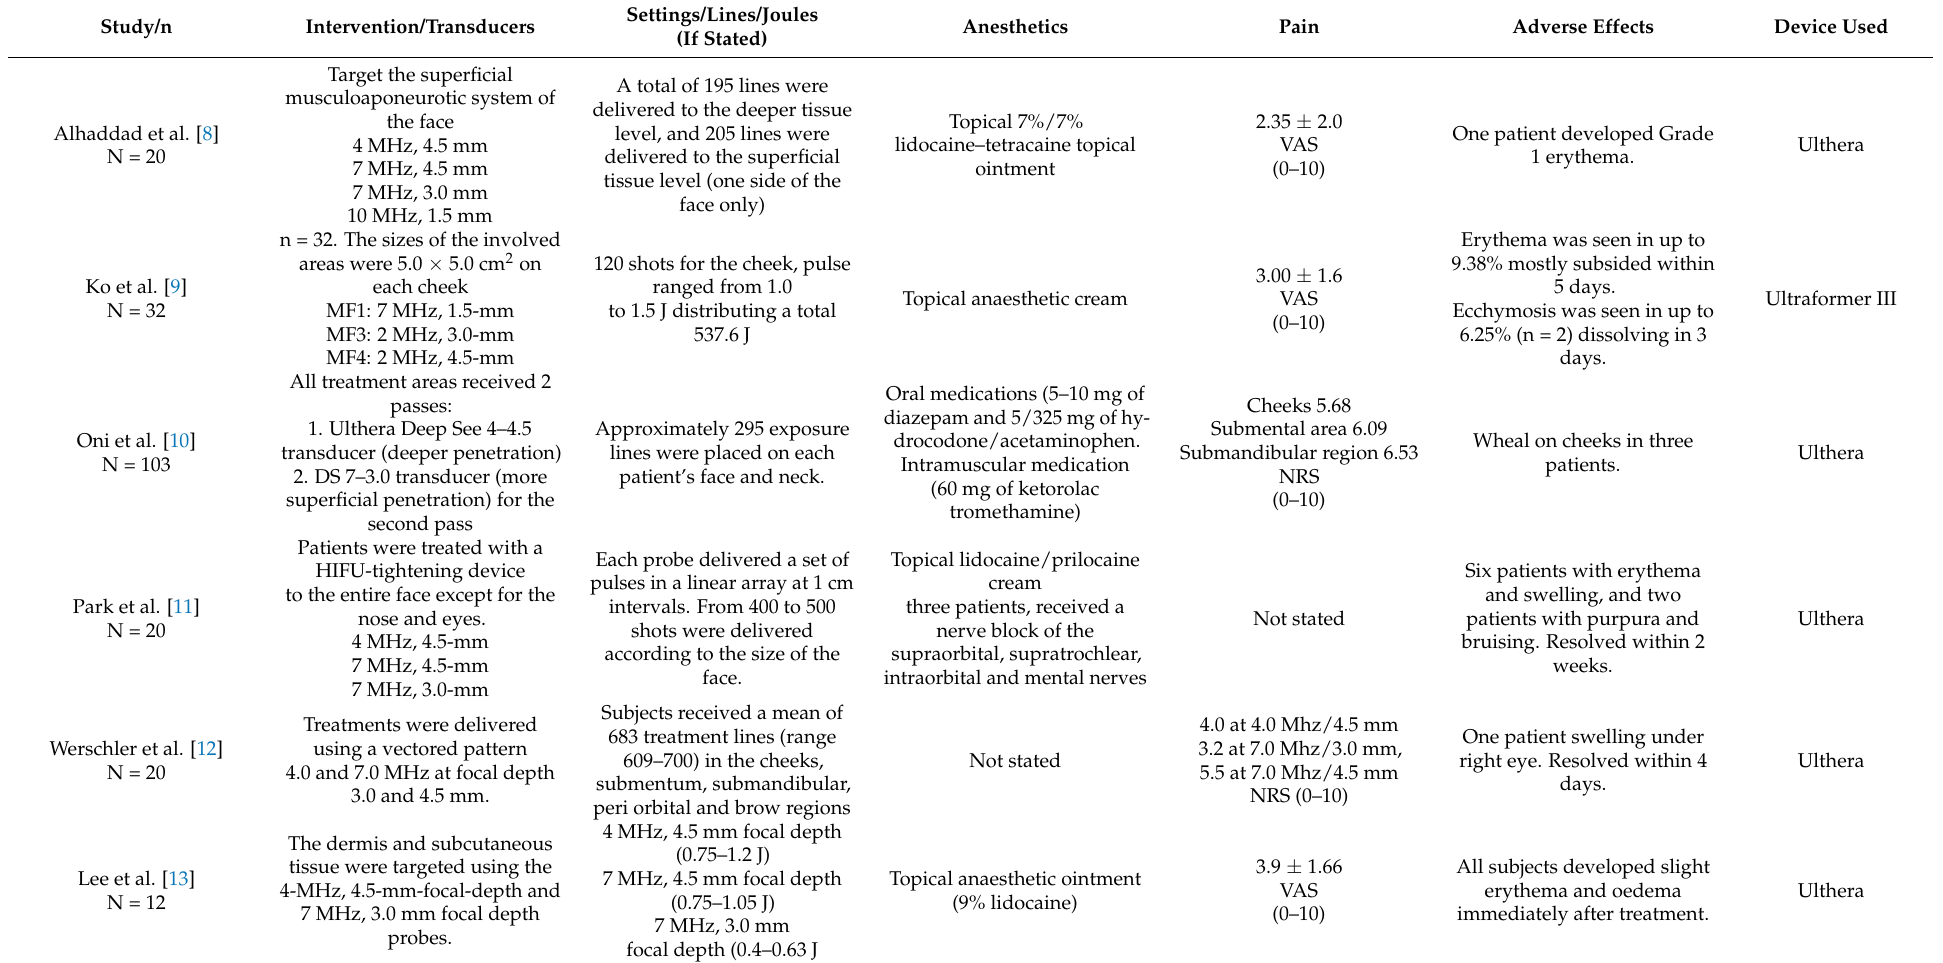
Table 2. Overview of treatment protocols (device, settings, anaesthetic used), pain, and adverse